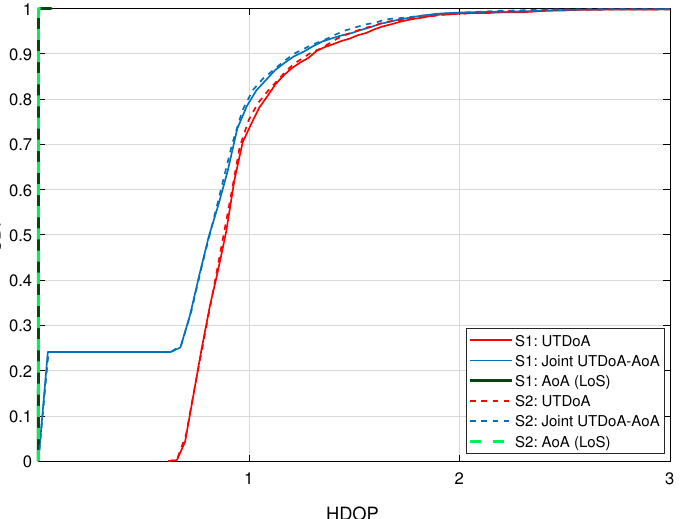
Figure 4. CDF of the HDOP for UTDoA, AoA and hybrid solution. S1 refers to first scenario and S2 refers to the second